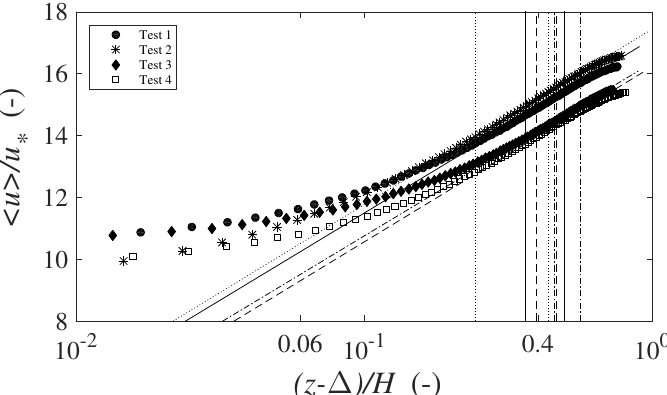
Figure 6. Double-averaged longitudinal velocity profiles and regression lines for the computation of the scale of the roughness elements k s , for Scenario 2 ( κ = 0.405, B = 8.5). The bounds of the regression lines are marked with the solid line (Test 1), dash-dot line (Test 2), dashed line (Test 3), and dotted line (Test 4).